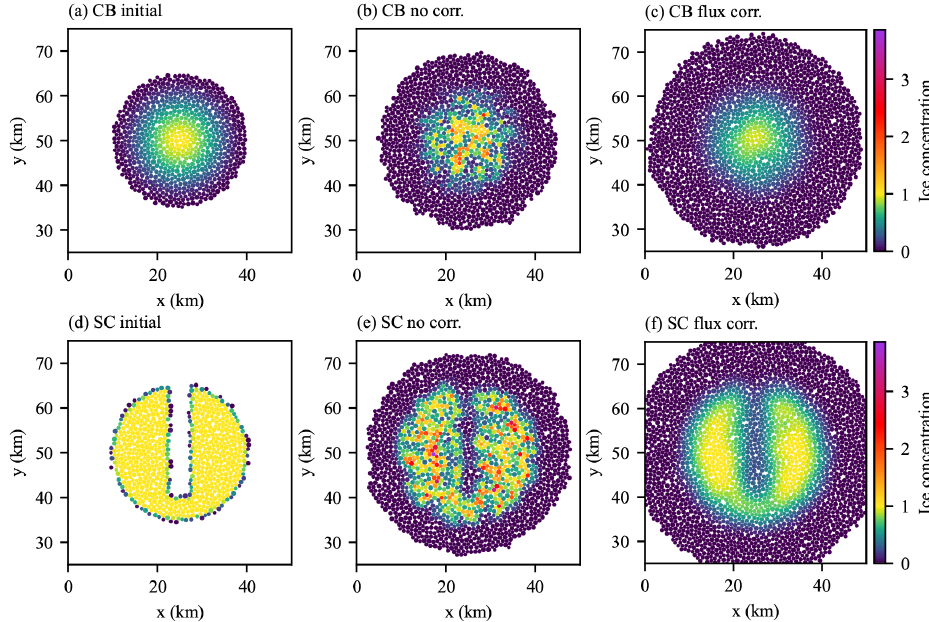
Figure 8. Stationary two-dimensional remapping test case with randomization of element orientations for cosine bell (CB: a–c ) and slotted cylinder (SC: d–f ) initial distributions. Shown are the initial sea ice concentration distributions ( a and d ), results without flux correction ( b and e ), and results with flux correction ( c and f ).